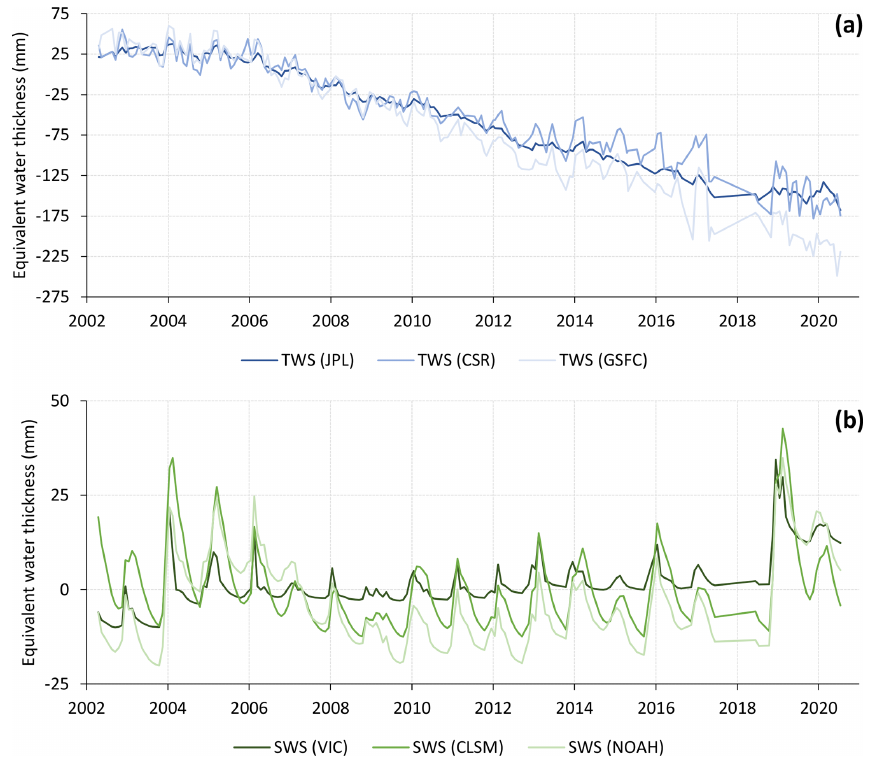
Figure 3. Monthly times series of (a) the GRACE-JPL, GRACE-CSR, and GRACE-GSFC terrestrial water storage anomalies (TWS; mm) and (b) the GLDAS-VIC, GLDAS-CLSM, and GLDAS-NOAH soil water storage anomalies (SWS; mm) of the Saq–Ram